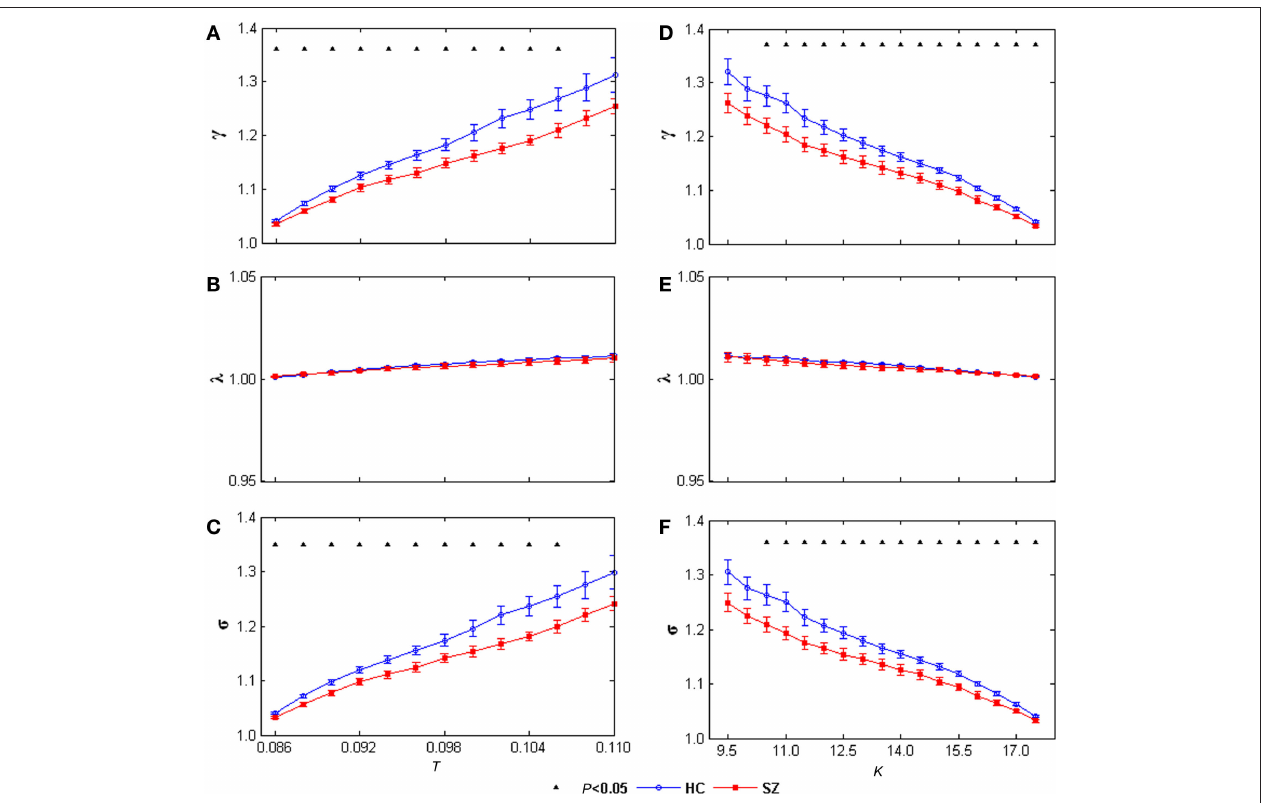
Figure 6 | γ (A), λ (B) , and σ (C) of the right task-related networks for HCs (blue circles) and SZ (red squares) as a function of threshold T . γ (D) , λ (e) , and σ (F) of the right task-related networks for HCs (blue circles) and SZ (red squares) as a function of degree K . Error bars correspond to SEM (across 20 subjects of each group), Black triangles indicate where the group difference is significant ( t -test, df = 38, P < 0.05, FDR correction for multiple